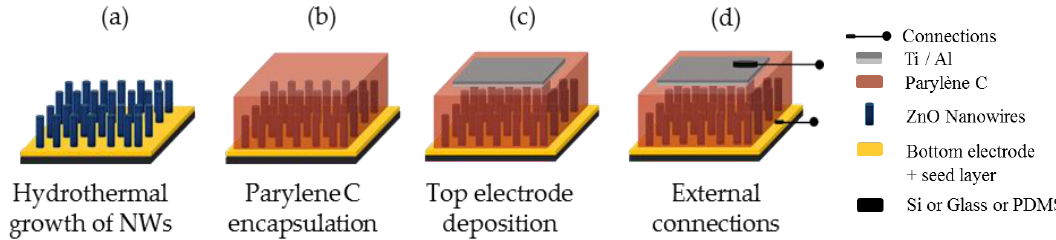
Figure 2. Piezoelectric nanogenerator (PENG) fabrication process ( a ) hydrothermal synthesis of ZnO NWs; ( b ) parylene C encapsulation; ( c ) top electrode deposition and ( d ) connection of the wires.